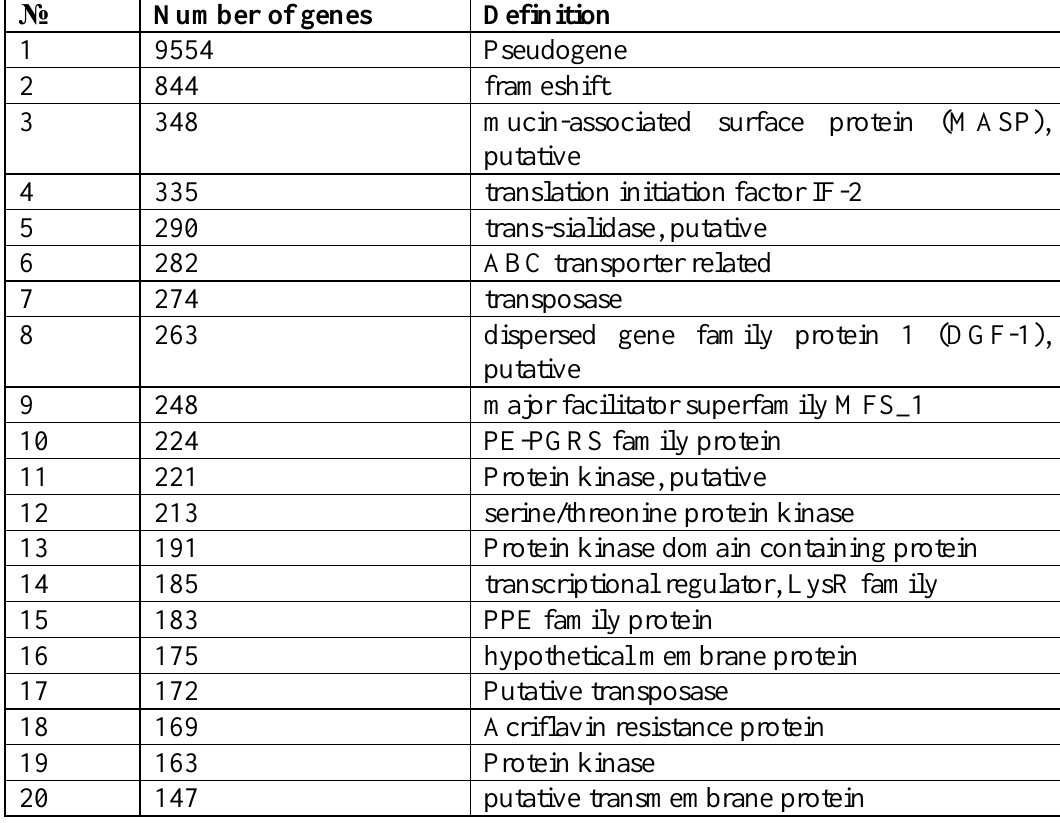
Table 1. The number of genes with TP phase shifts grouped by the identical description of biological function in Kegg data